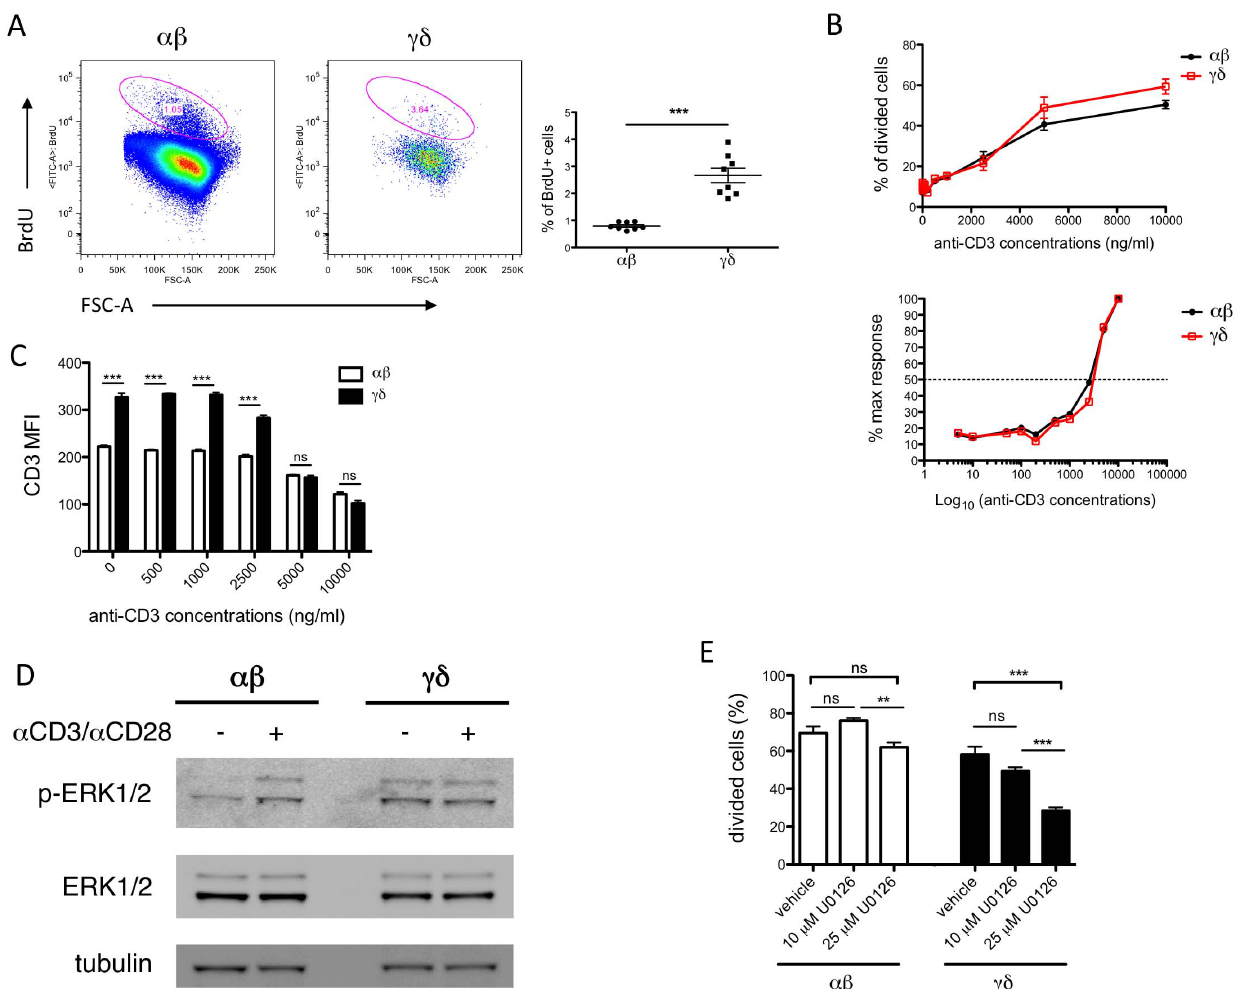
Figure 4. cd T cells have similar TCR threshold but enhanced ERK1/2 phosphorylation comparing to ab T cells. (A) Percentages of BrdU + proliferative cells are higher in the cd T cell subset in vivo . Left: representative plots of BrdU + populations (circled) in ab and cd T cells. Right: Graph of percentages of BrdU + cells in ab and cd T cells. C57BL/6J mice received single dose of BrdU (1 mg) via intraperitoneal injection, and splenocytes were isolated 3 days later. BrdU + cells were identified by fluorescently labeled anti-BrdU antibody and flow cytometry. Results were averaged from 8 mice, and shown in mean 6 SEM. *** P , 0.001. (B) Top: Splenocytes from C57BL/6J mice were labeled with CFSE (2.5 m M), and then stimulated with 0– 10 m g/ml plate-bound a CD3 and 1 m g/ml soluble a CD28 for 24 hours. CFSE content in cells was measured by flow cytometry and graphed against a CD3 concentrations. Results were averaged from 5 mice, and shown in mean 6 SEM. Lower: Log scaling of a CD3 concentration against % of maximum response was used to calculate EC 50 . (C) CD3 expression in cd T cells was higher than in ab T cells under no or lower stimulation, but decreased more dramatically with stronger stimulation. The experimental condition was the same as in (B). (D) Western blotting shows high levels of phosphorylated ERK1/2 in cd T cells, relative to ab T cells, at baseline. ab and cd T cells were isolated from the same set of C57BL/6J mice via FACS sorting. Cells were either untreated, or incubated with a CD3 and a CD28 antibodies (20 m g/ml each) for 5 minutes and then with anti-hamster IgG (20 m g/ml) for additional 2 minutes at 37 u C. Cells were lyzed, separated by SDS-PAGE, and immunoblotted with indicated antibodies. The image was representative of 3 independent experiments. (E) Inhibition of ERK1/2 significantly lowers proliferation in cd T cells in vitro . Splenocytes from C57BL/ 6J mice were labeled with CFSE (2.5 m M), and then stimulated with 1 m g/ml plate-bound a CD3 and 1 m g/ml soluble a CD28 for 24 hours, in the absence (vehicle) or presence of 10 m M and 25 m M U0126. CFSE dilution in cells was measured by flow cytometry, and used to calculate cell proliferation. Results were averaged from 7–8 mice, and shown in mean 6 SEM. ** P , 0.01; *** P , 0.001; ns not statistically